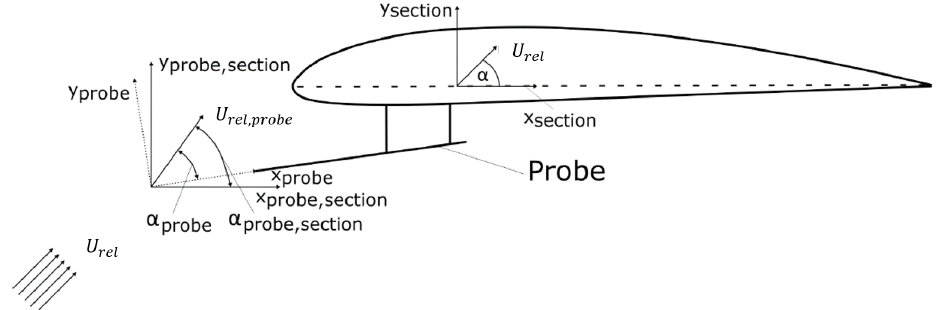
Figure 9. Schematic of the reference system for a probe, modified from Klein et al. (2018).